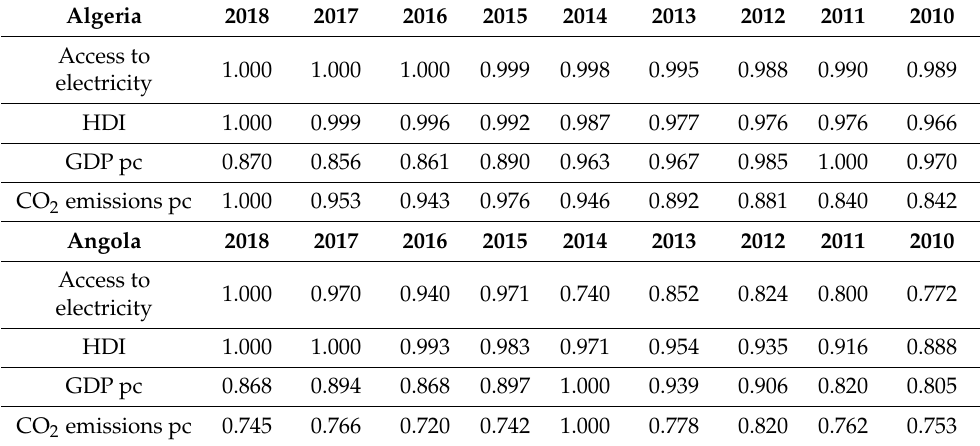
Table 4. Time series standardized against their maximum values for two selected African countries. Source: own calculations.